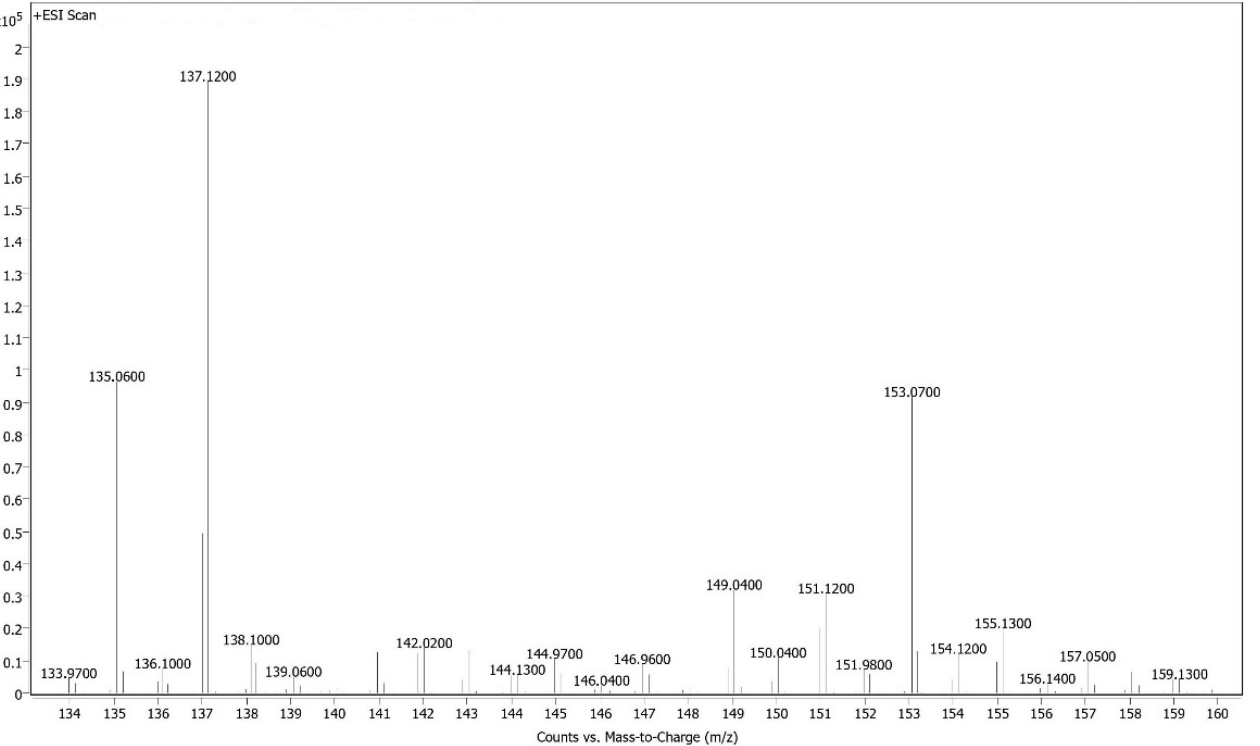
Figure 2. Mass spectra for the Avicenna tea tree essential oil under study.